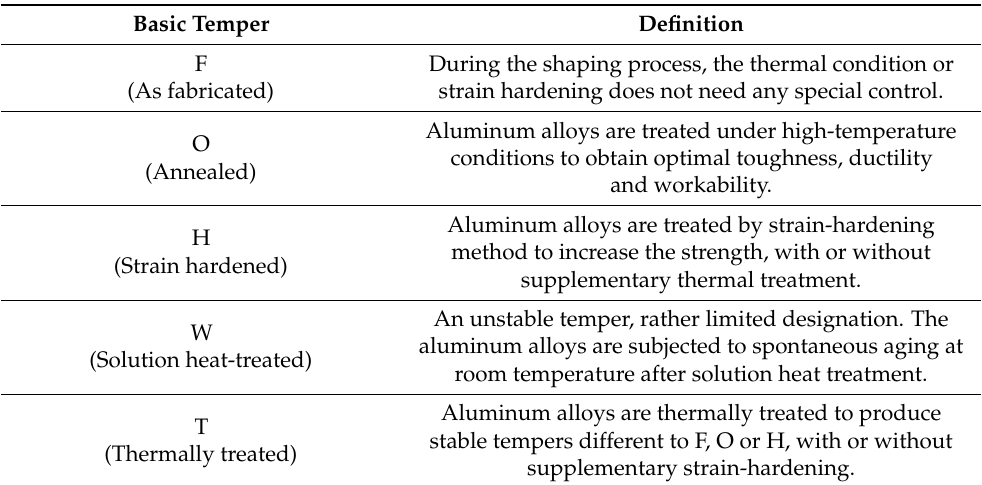
Table 2. Basic temper designation of aluminum alloys. Adapted from